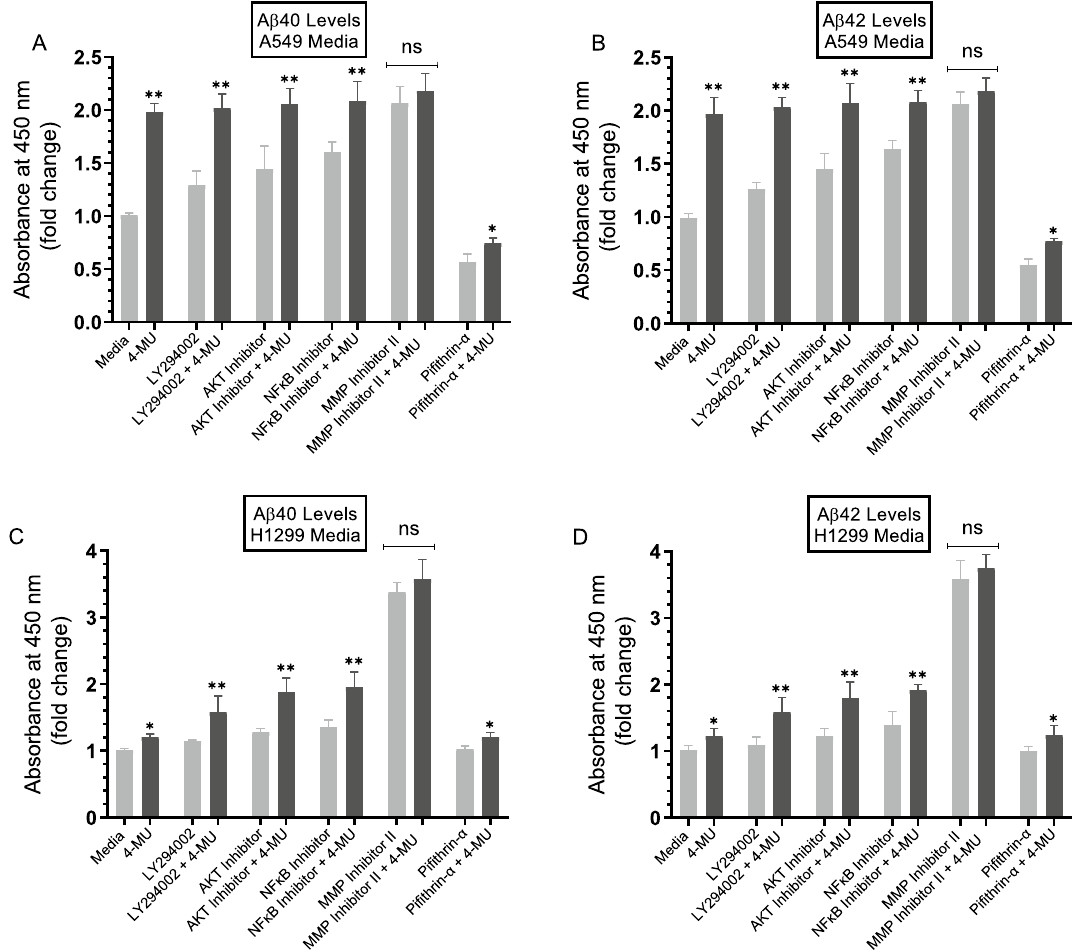
Figure 3. Treatment of cells with the MMP2/9 inhibitor resulted in comparable increases in the levels of Aβ in the media of both A549 and H1299 cells as that upon cell co-treatment with 4-MU, while Aβ levels decreased upon treatment with 4-MU and the p53 inhibitor, pifithrin-α, in A549 cell media only. Cells (0.2 × 10 5 ) were grown in 10% FBS-supplemented media for 24 h. The following day, the cell monolayers were incubated in serum-free media for 24 h, then treated as indicated for 72 h with the inhibitors, without and with added 600 µM 4-MU, as described in the “Methods” section. The media was collected then the same amount of protein (3 µL of 600 µg/mL total protein) of each sample was used to quantitate Aβ40/42 (“Methods” section). Data from five independent assays, each carried out in triplicate, were quantitated, averaged, normalized, and expressed as fold change relative to control cells not treated with 4-MU using the GraphPad 8.4.3 software. The graphs summarize the results expressed as means ± SD (n = 5). Asterisks (*) indicate a statistically significant difference from the corresponding cell line control, * p < 0.05, ** p < 0.01 of each cell line. Absence of asterisks indicates no significance (ns), Mann–Whitney